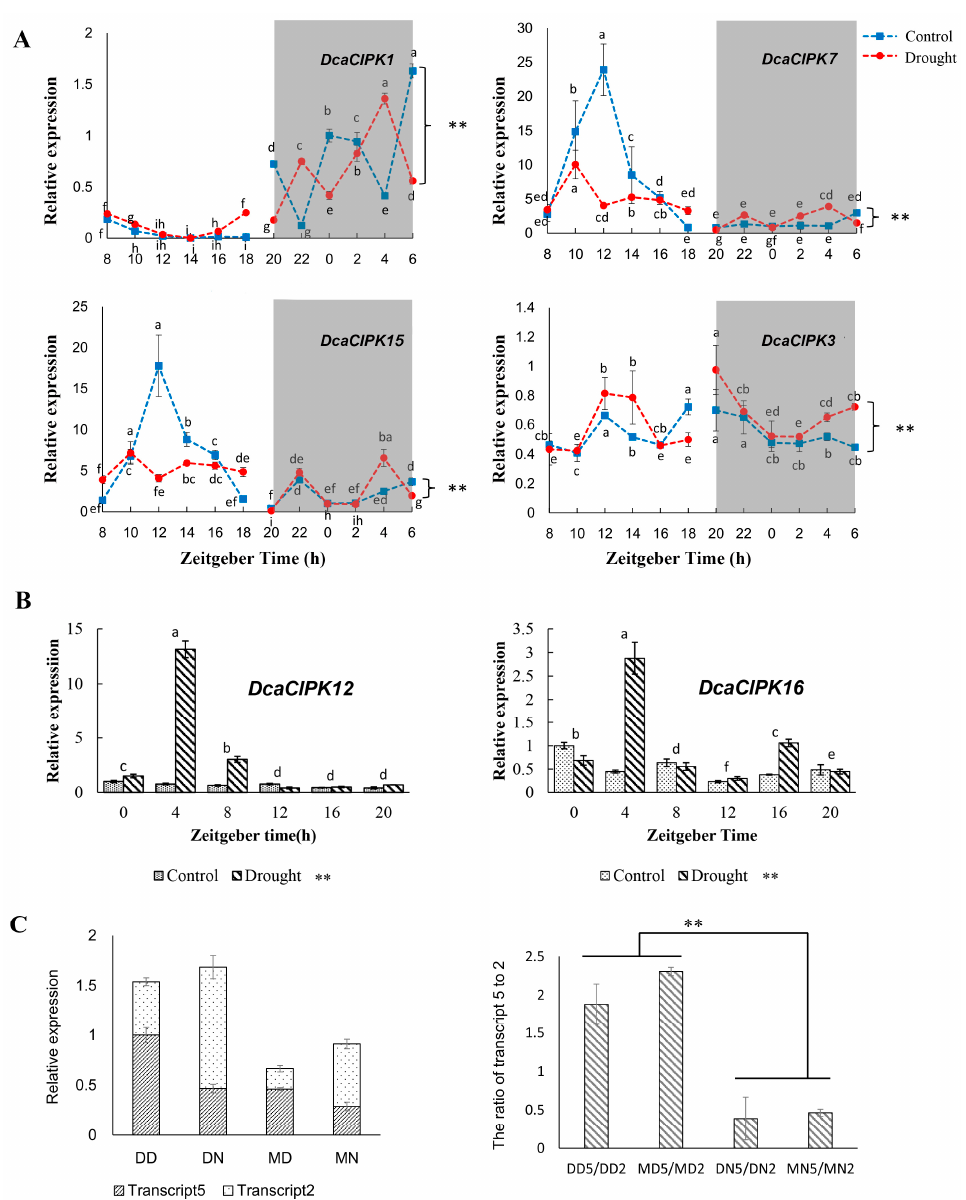
Figure 9. ( A ) Effect of time-of-day on Dca CIPK genes expression induced by drought stress. Different letters above the line points indicate statistically significant differences among sampling time treatment at the same base material water content level ( p < 0.05). ( B ) Effect of drought treatment on Dca CIPK gene expression. Light phase began at Zeitgeber Time 6 (ZT6) and dark phase (shaded areas) began at ZT18. Data are presented as mean ± SEM. Experiments were performed 4 times. * indicates differences the effect of base material water content is significant. Different letters above the column indicate statistically significant differences among sampling time treatment ( p < 0.05). ( C ) Relative abundance of drought treatment on transcripts (2 and 5) of DcaCIPK3 expression. DD represents drought treatment in daytime; DN represents drought treatment in nighttime; MD represents moist treatment in daytime; MN represents moist treatment in nighttime. “2” and “5” after “DD, MD, MN, and MN” represent transcript2 and 5, respectively.